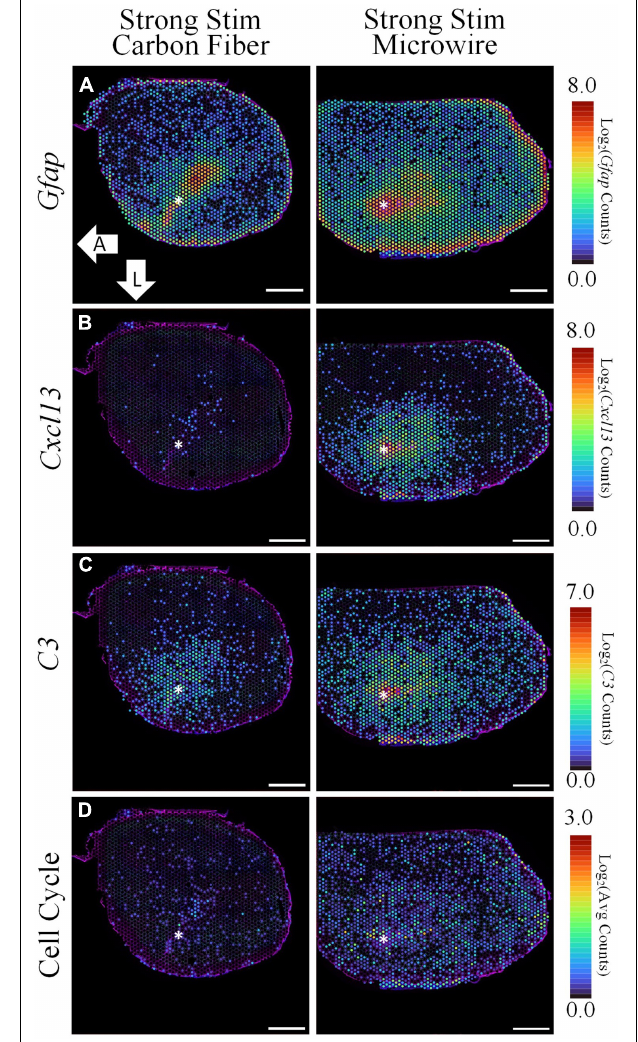
FIGURE 7 | The spatial pattern of selected differentially expressed genes illustrate the upregulation of inflammation and cell cycle-associated pathways following electrical stimulation delivered by a MWA in comparison to a HDCF. While Gfap is notably increased in both samples, stimulation delivered by the MWA is associated with genes included in a cytotoxic, “Cell-Killing” gene ontology term ( C3 , Cxcl13 ). A less prominent, but significant, upregulation of cell cycle-associated genes with the MWA-stimulation condition was an unexpected result revealed by the spatial transcriptomics assay. Average expression of DE genes making up the “Cell Cycle” GO Term is shown. Asterisks denote estimated implant site and arrows denote direction (L: lateral, A: anterior). Scale bars: 1.0